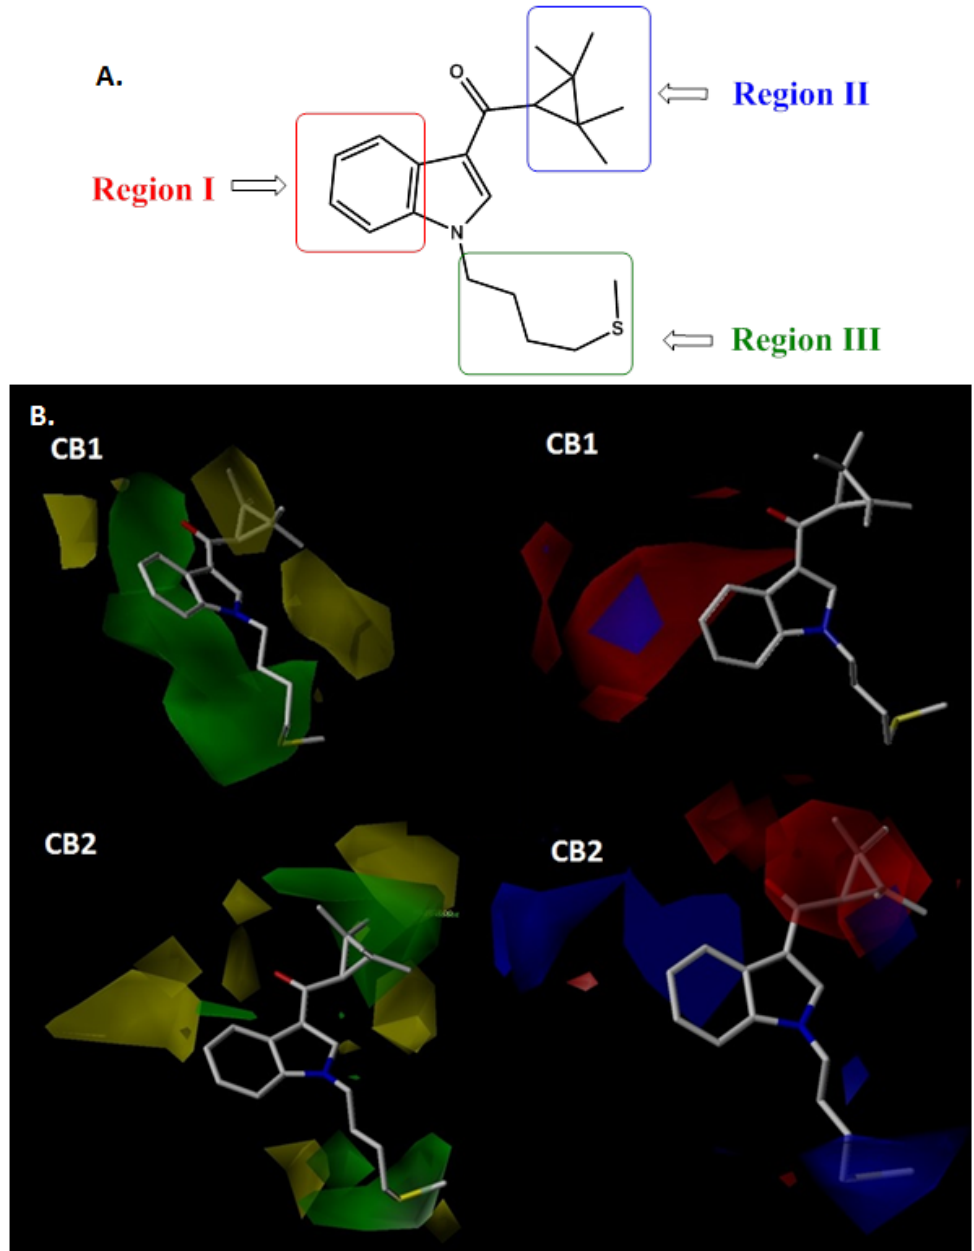
Figure 3. A . Molecular Regions analyzed. B . CoMFA steric (left) and electrostatic (right) contour maps for CB1 and CB2 receptors around compound 90 , the most active of the series. Sterically favored (green) and disfavored (yellow); electropositive (blue) and electronegative